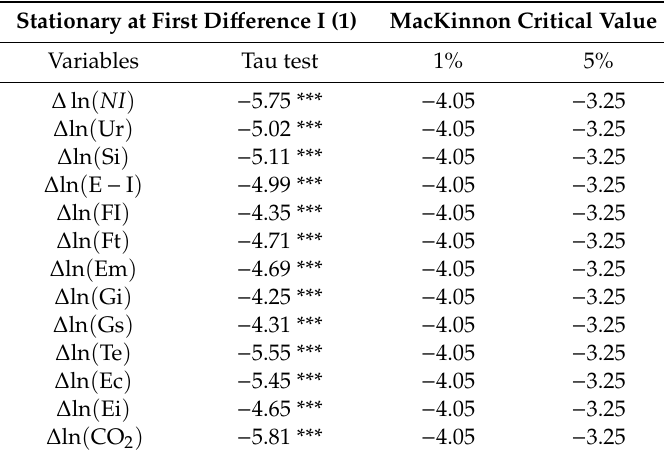
Table 1. Stationary test at first di ff erence I (1).